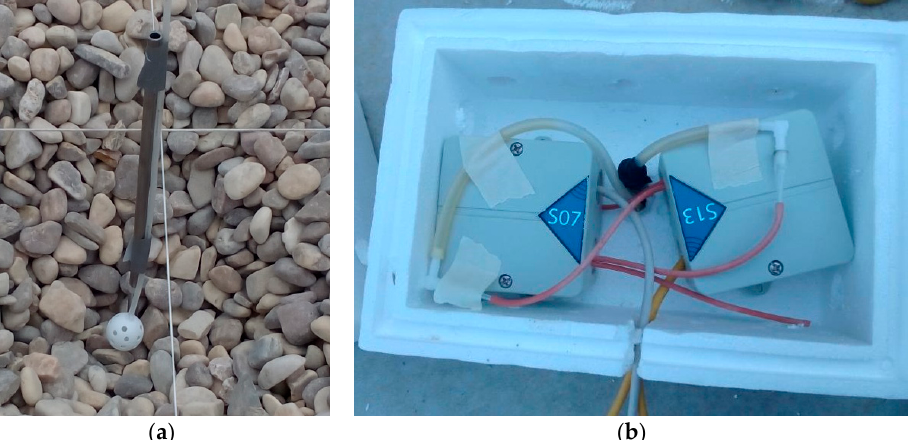
Figure 15. ( a ) Tube insertion on ground and gravel. ( b ) Double sensor connection on the experimental slab.